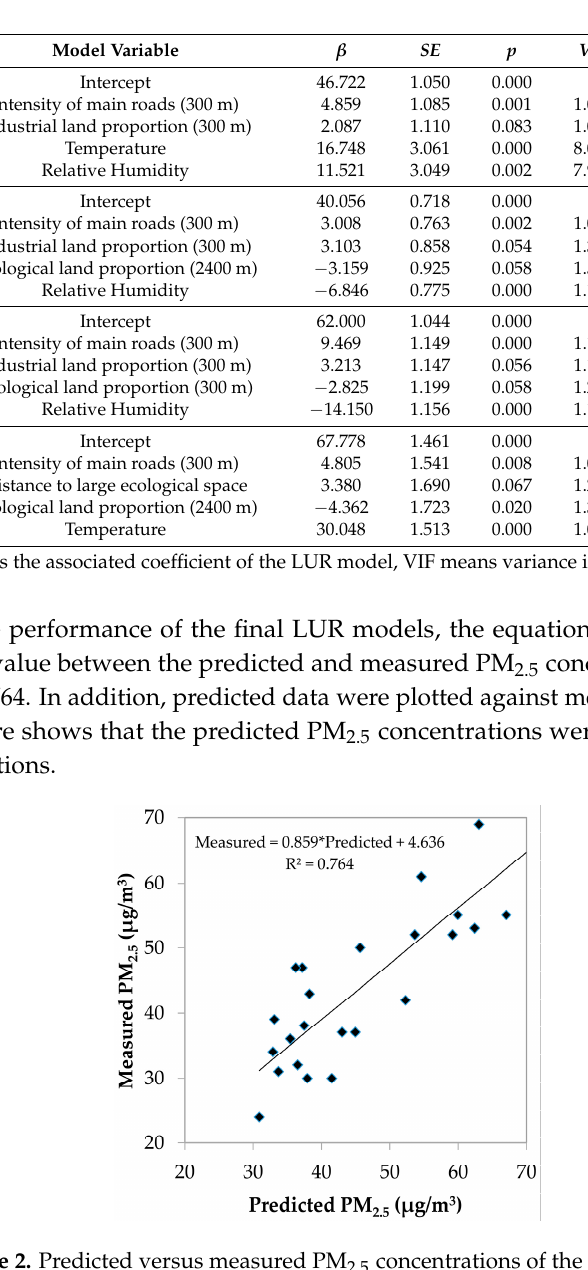
Table 3. The final land use regression (LUR) models for PM 2.5 concentrations in the Nanchang urban area.